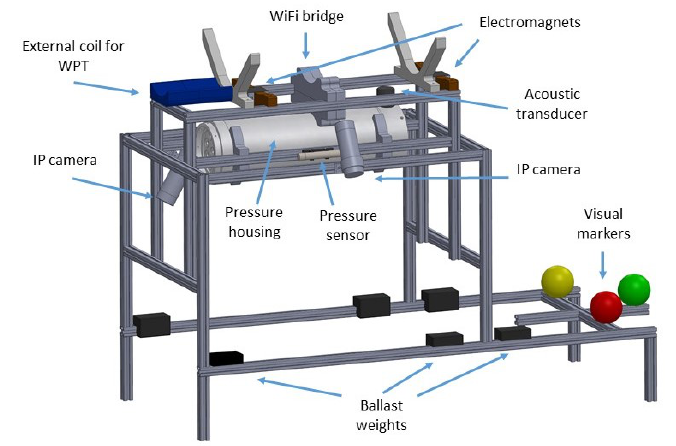
Figure 3. Docking